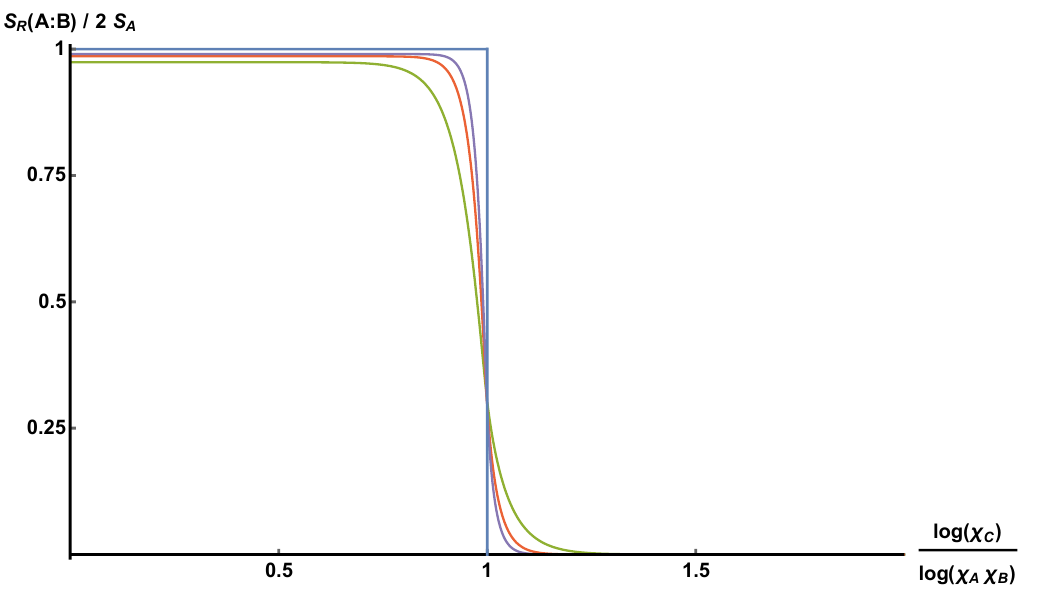
Figure 2 . “Page curve” of the reflected entropy, for a single tripartite random tensor with bond dimensions χ . The blue curve corresponds to the infinite bond dimension limit, χ → ∞ . A , χ B , χ C The other curves correspond to large but finite bond dimension, correctly limiting to the blue curve as the bond dimension